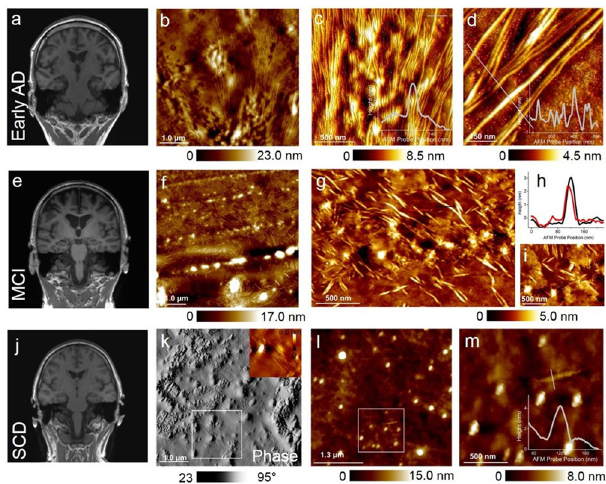
Fig. 2 Brain scans and AFM analysis of CSF from individuals with early- onset AD dementia (patient ID: KSSG:15), mild cognitive impairment due to AD (patient ID: KSSG:2) and with SCD and patients with no evidence of AD pathology (patient ID: KSSG:19). a Representative T1-weighted coronar MRI scan showing moderate bilateral hippocampal atrophy (MTA 2) of patient KSSG:15 with early-onset AD dementia. b AFM height image of sparsely distributed ultralong protein fi brils resolved in CSF of patient KSSG:15. c , d High-resolution and three-dimensionally rendered AFM height maps of single fi brils resolved within areas in panel b . The cross-sectional pro fi le extracted on single fi brils is provided in the bottom right inset of c and d . e Representative T1-weighted coronar MRI brain scan of patient KSSG:2 with MCI due to AD showing moderate global atrophy with a frontal and parietal predominance (GCA 1-2). f Large-area AFM height image of fi brillar aggregates present in CSF of a patient KSSG:2. g 3-D rendered AFM height image recorded in a region within panel f showing clearly shorter and sparsely distributed fi brillar aggregates. h Cross-sectional pro fi les were extracted along the red and black lines indicated in panel g . In addition to the short protein fi brils, nanometer sized thin fi lms and spherical particles are also visible in the AFM height images in panels f , g and i . j representative T1-weighted coronar MRI brain scan of patient KSSG:19 with SCD with no evidence for AD pathology showing no signs of atrophy. k Large-area phase AFM image recorded on CSF from patient KSSG:19. The AFM image reveals mainly spherical particles distributed in the CSF medium. Fibrillar aggregates were also detected as highlighted in the spatially magni fi ed height image (top right inset of k ) within the white box indicated in k . l AFM height image was recorded within another region of the same substrate (CSF from patient KSSG:19) showing predominantly spherical aggregates and isolated single fi brils with nodular morphology as indicated in a white box. m High-resolution AFM height map recorded within the region indicated by the white box in l and the corresponding sectional pro fi le extracted across the single proto fi bril is shown in the bottom right inset.